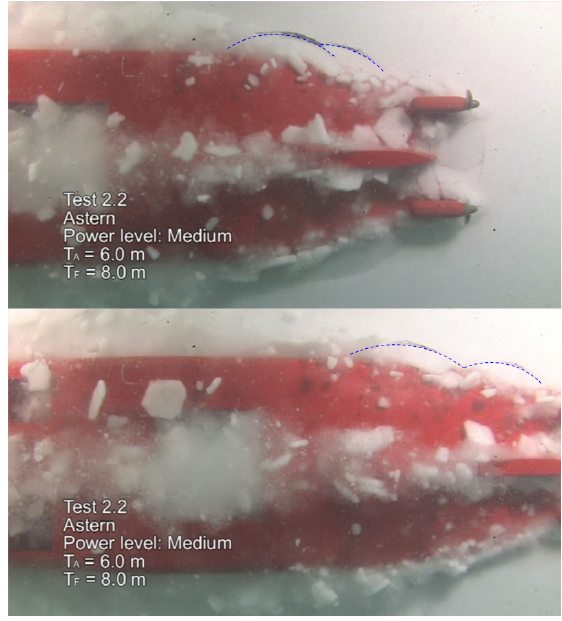
Figure 9: Screenshots from an icebreaking run in ice basin, running astern in 33 mm (0 . 80 m full- scale) level ice.